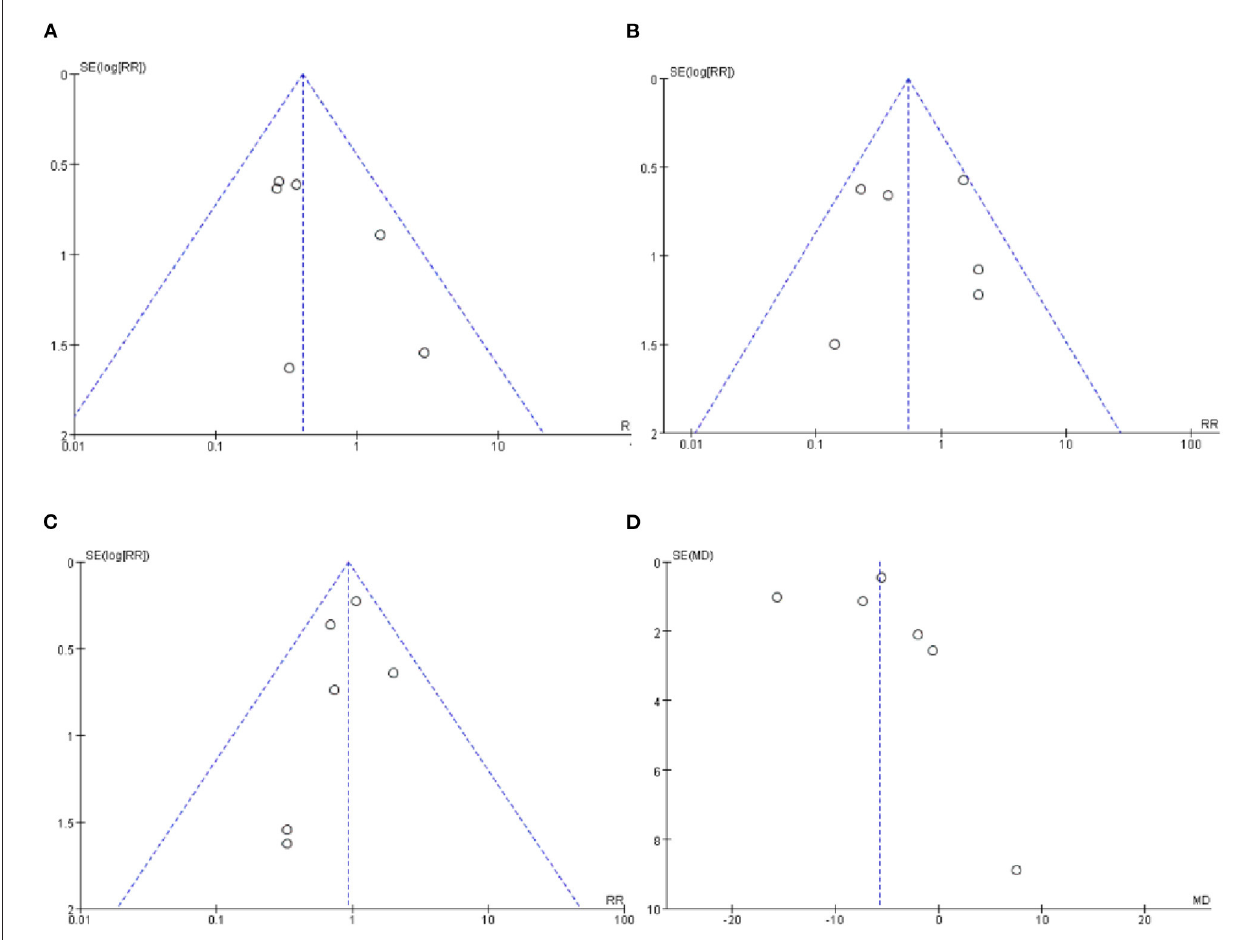
FIGURE 6 | (A) Funnel plot of the incidence of VAP. (B) Funnel plot of the incidence of NEC. (C) Funnel plot of the mortality during hospitalization. (D) Funnel plot of the